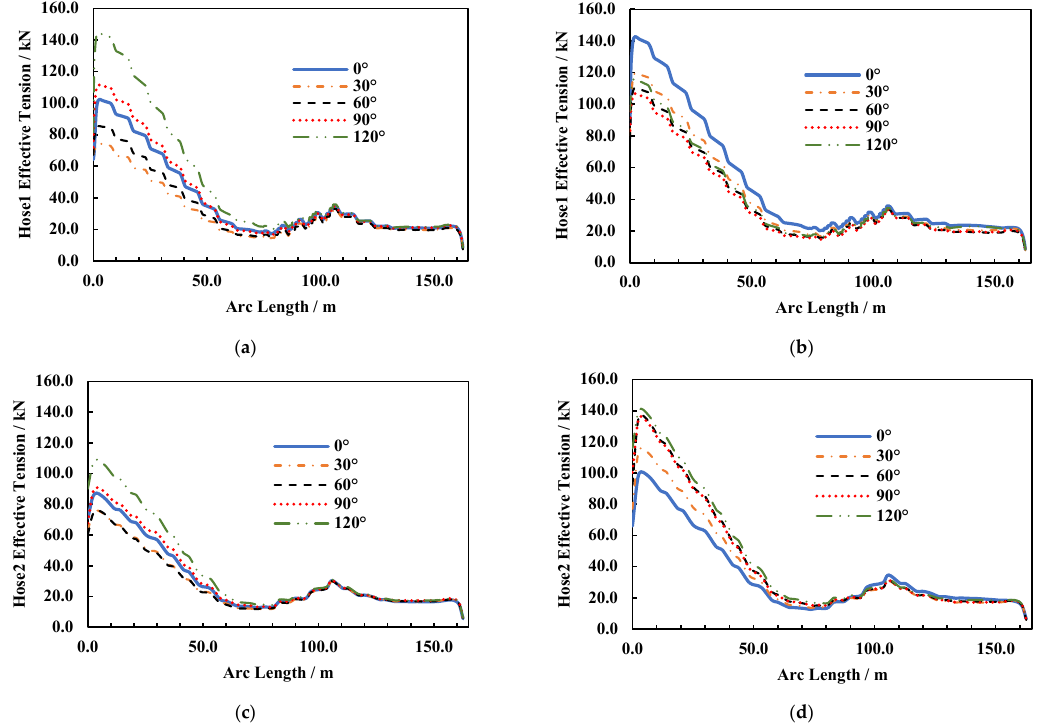
Figure 23. Influence of RAOs on Effective Tension for different wave directions. Figures ( a , c ) are when the hoses have RAO loads, while Figures ( b , d ) are when the hoses are without RAO loads for the submarine hoses in Lazy-S config.( a ) Hose1 Effective Tension including hose hydrodynamic load. ( b ) Hose1 Effective Tension excluding hose hydrodynamic load. ( c ) Hose2 Effective Tension including hose hydrodynamic load. ( d ) Hose2 Effective Tension excluding hose hydrodynamic load.